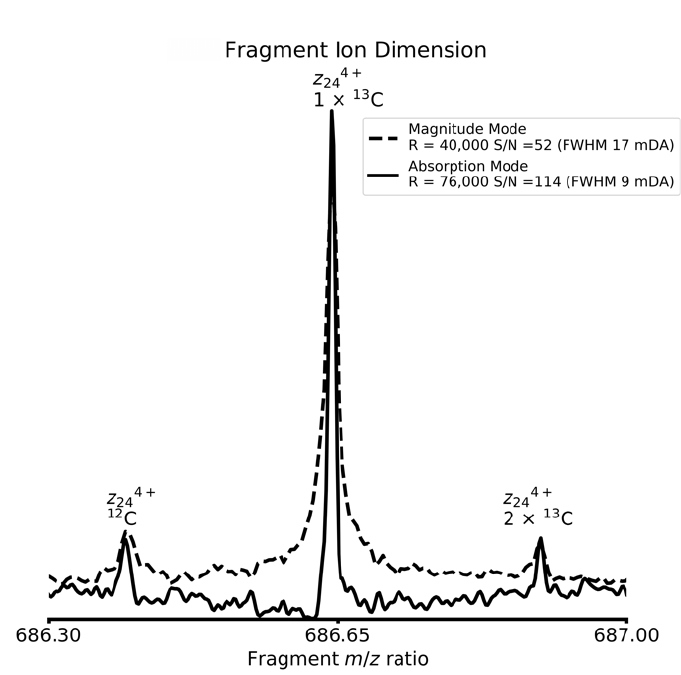
Figure 2. Extracted fragment ion scan from the 2D mass spectrum for the 1 × 13 C isotope of [M + 6H] 6+ ions of the monomethylated histone peptide (K7 1m) at m/z 489.453, zoom-in on fragment ion z 244+ , comparison between absorption mode and magnitude mode.